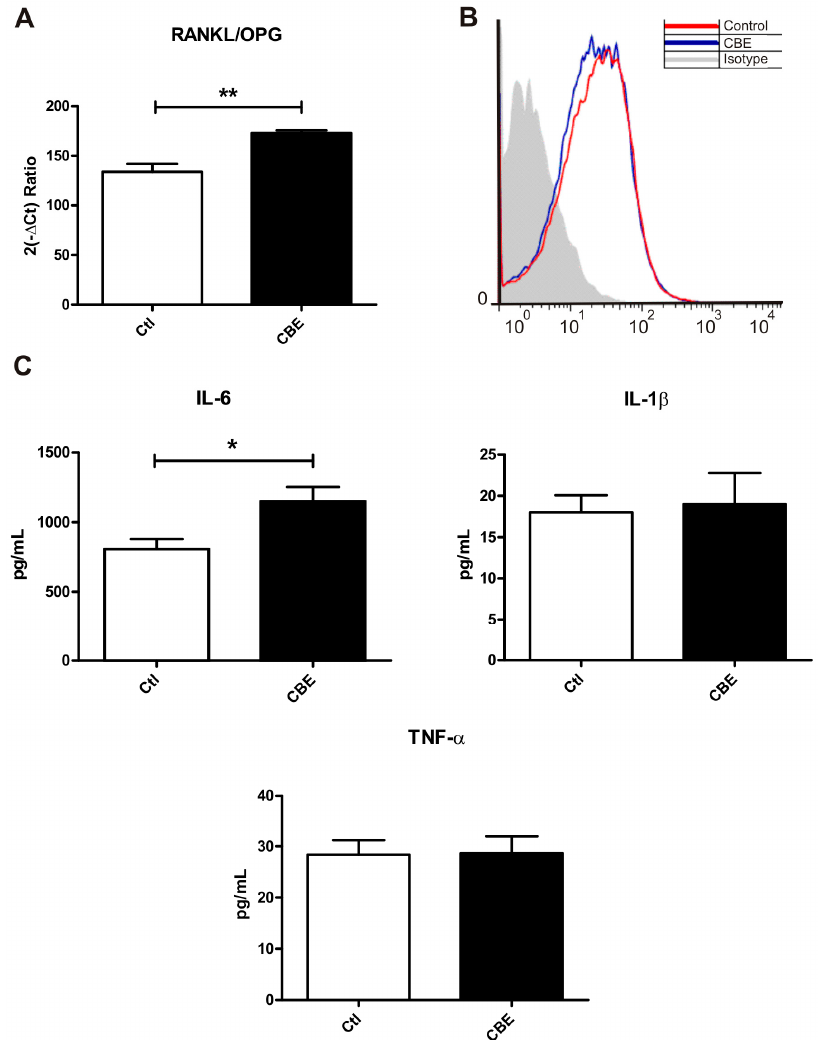
Figure 5. RANKL/OPG ratio and interleukin 6 (IL-6) are increased by CBE treatment. MLO-Y4 cells were treated with CBE for 7 days. Cells and conditioned media were harvested. Cells were used for qPCR analysis and the ratio between the mRNA levels for RANKL and OPG was evaluated ( A ); the conditioned media was centrifuged to obtain the fraction containing the apoptotic bodies and the supernatant fraction. Surface levels of RANKL in the fraction containing the apoptotic bodies were analyzed by flow cytometry ( B ); a representative histogram of each condition, as derived from the three independent experiments conducted, is shown. IL-6 levels were evaluated by capture ELISA in the supernatant fraction ( C ). Data are expressed as mean ± SD ( n = 5) and are representative of three independent experiment performed. * p < 0.05, ** p < 0.01 t- test.